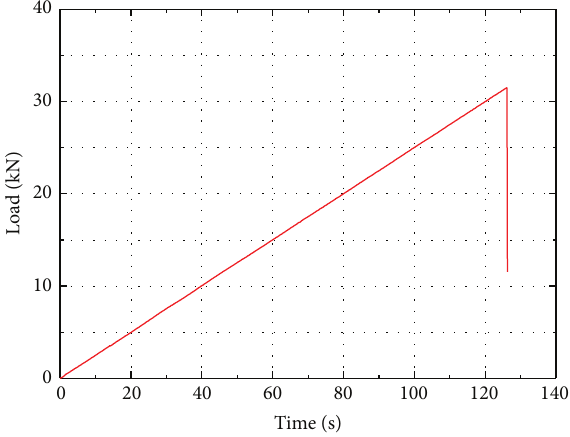
Figure 3: Typical load time curves for concrete specimen.